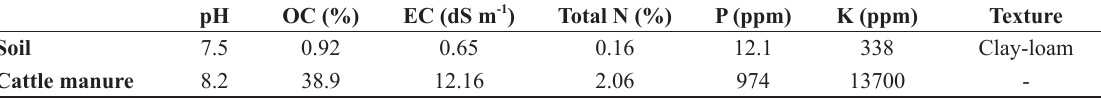
Chemical and physical characteristics of the soil and cattle manure used in the field